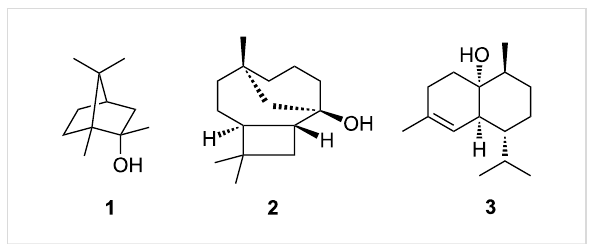
Figure 1: Terpenoids from Streptomyces griseus .